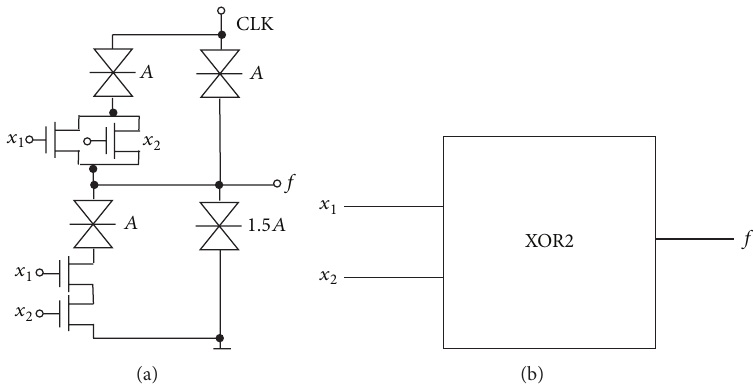
Figure 2: The bivariate XOR gate (XOR2), (a) schematic (b) symbol.